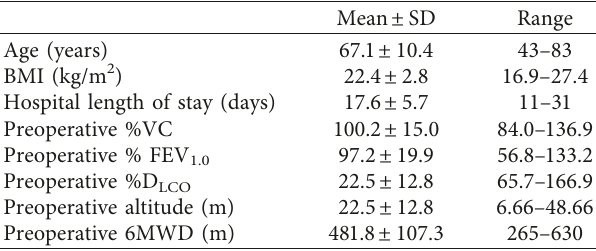
Table 1: Characteristics of the subjects in the study.